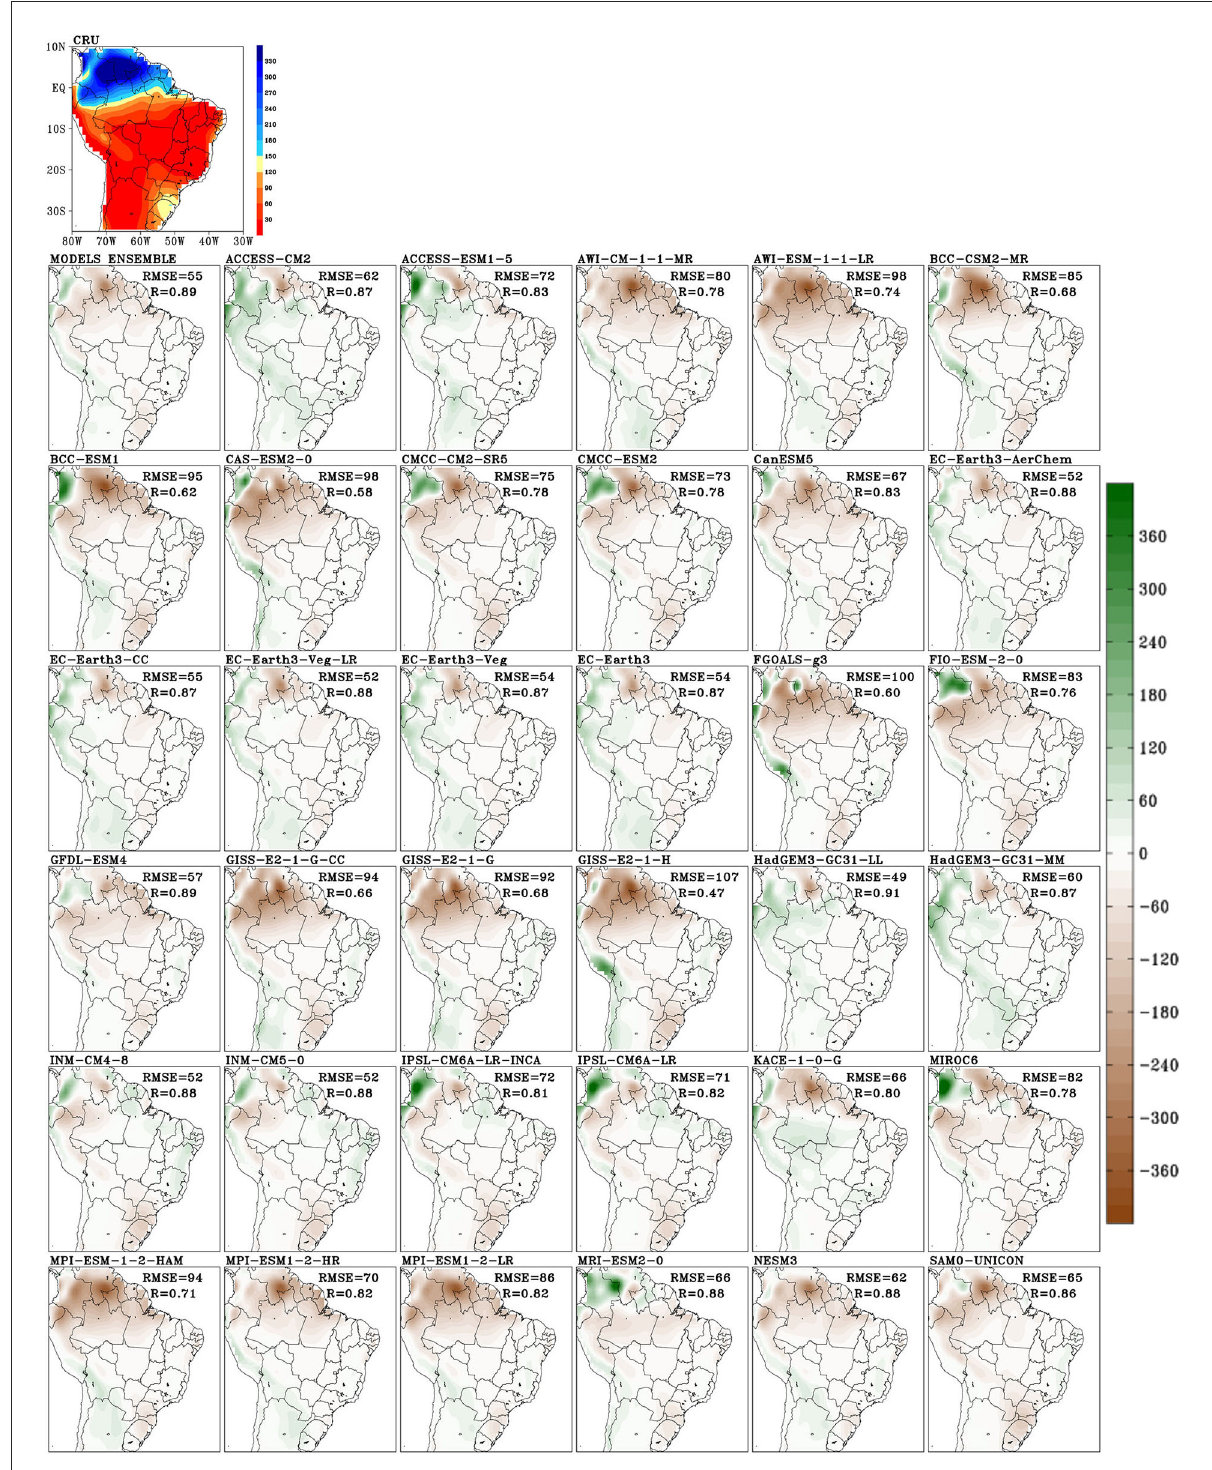
FIGURE7 CMIP6 model biases and CRU-observation (top left panel) for precipitation: Austral winter (JJA). Unit: mm/month.